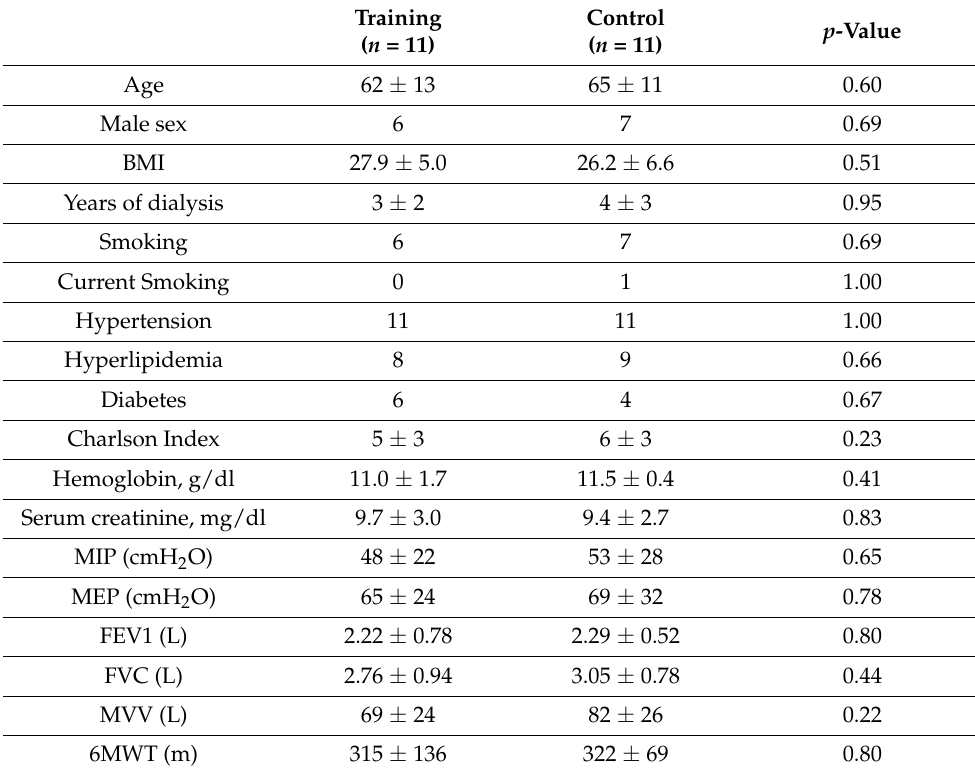
Table 1. Demographic and clinical characteristics of the sample at